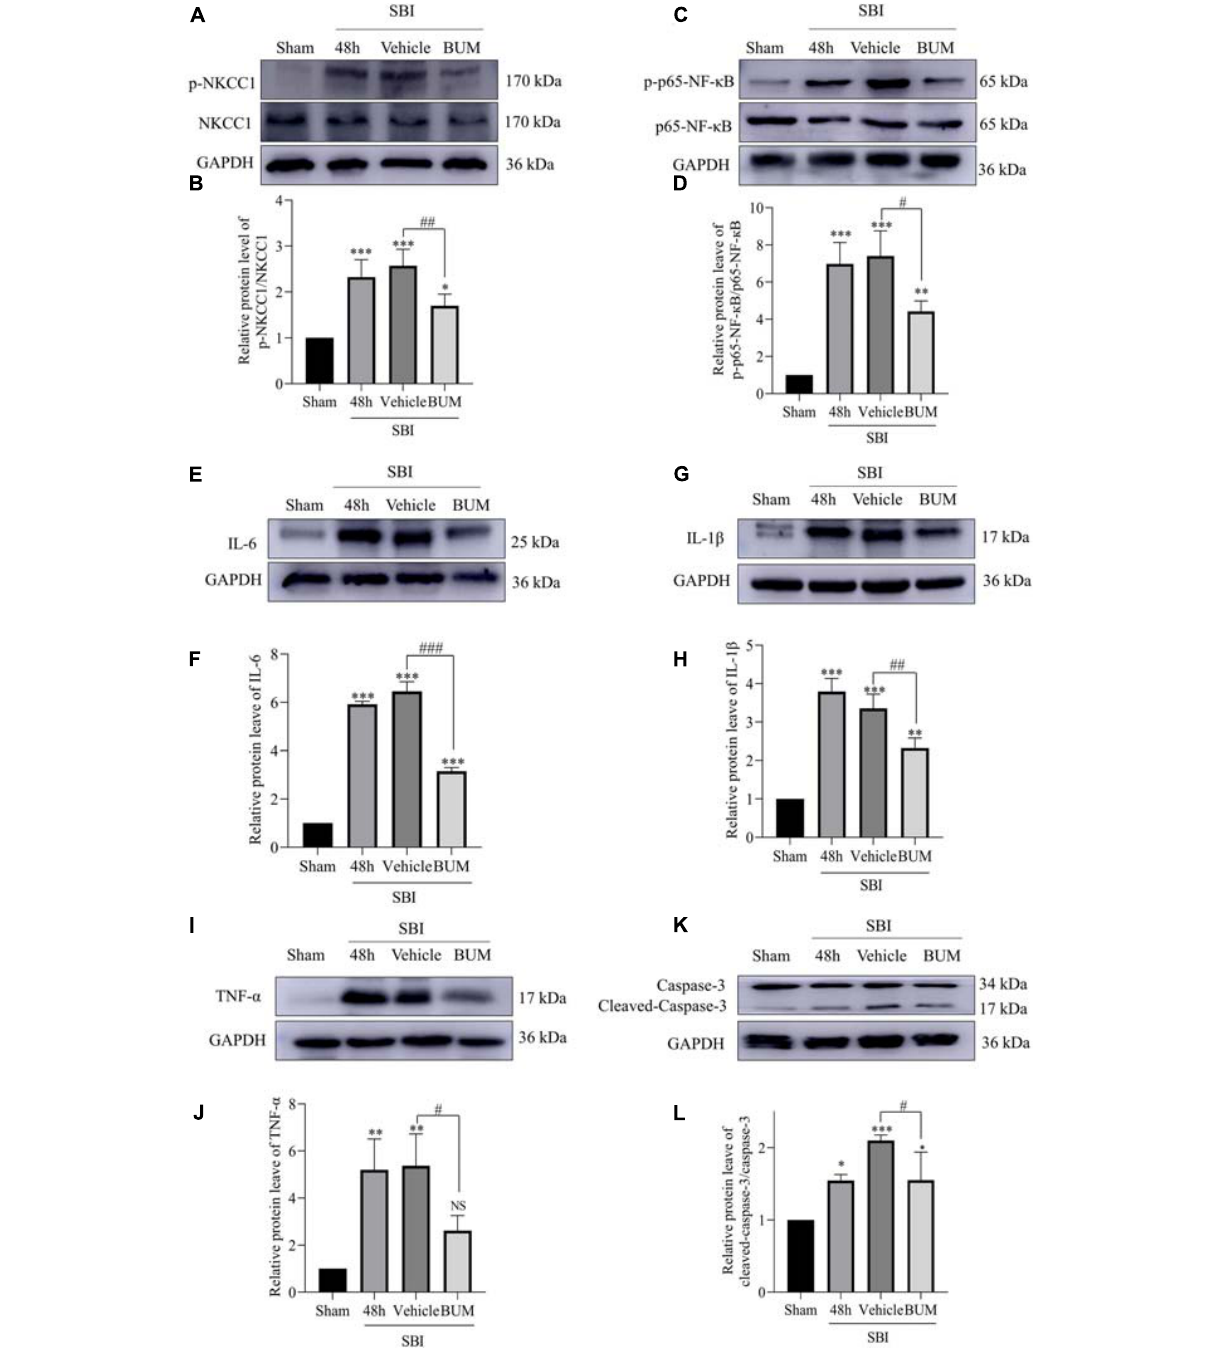
FIGURE 5 | Expression levels of related proteins after the intervention of BUM 48 h after SBI. The protein-expression levels of p-NKCC1 (A,B) , p-p65-NF- κ B (C,D) , IL-6 (E,F) , IL-1 β (G,H) , TNF- α (I,J) , and caspase-3 (K,L) were assessed to determine the effect of BUM intervention on peripheral cortex injury 48 h post SBI. Statistical analyses were performed by a K–W one-way ANOVA followed by the Student–Newman–Keuls post hoc test. n = 4 for each group. ** P < 0.01, *** P < 0.001 compared to the sham group. # P < 0.05, ## P < 0.01, ### P < 0.001 compared to the SBI + vehicle